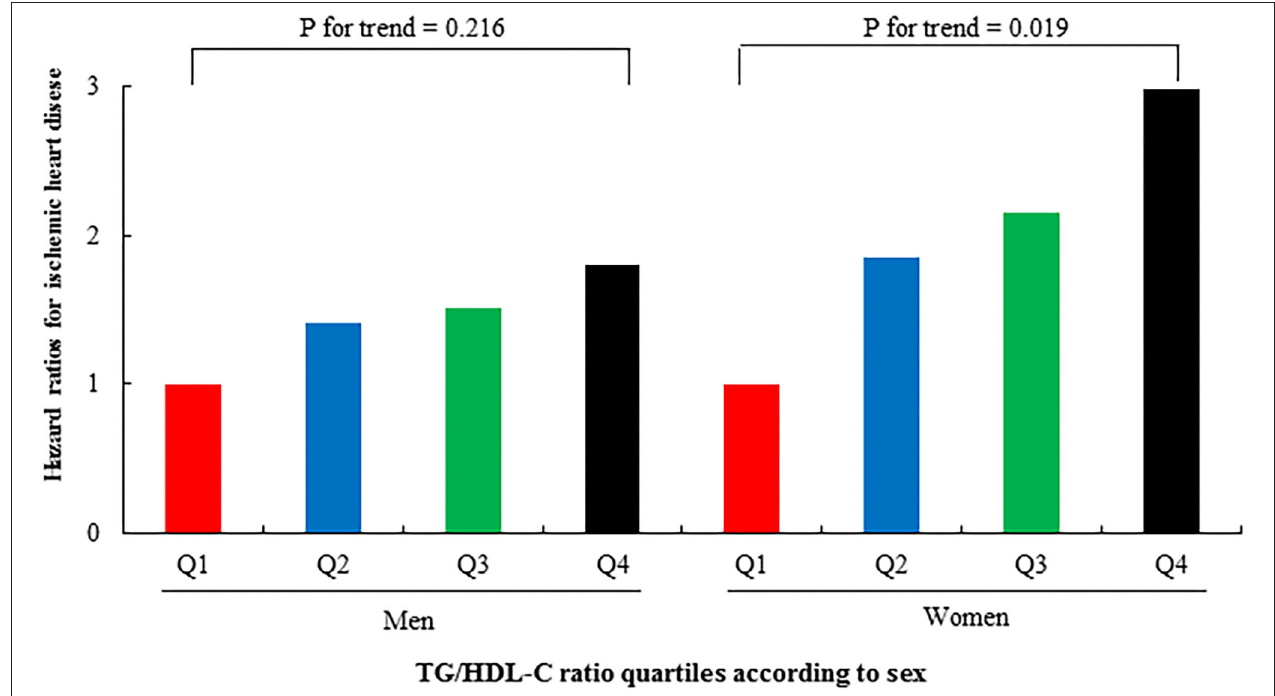
FIGURE 3 | Hazard ratios (95% CIs) for incident IHD according to TG/HDL-C quartiles after adjusting for potential confounding variables according to sex.